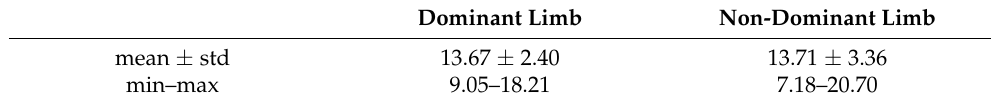
Table 10. Data obtained for the Upper Body Index indicator in the stroke patient group.